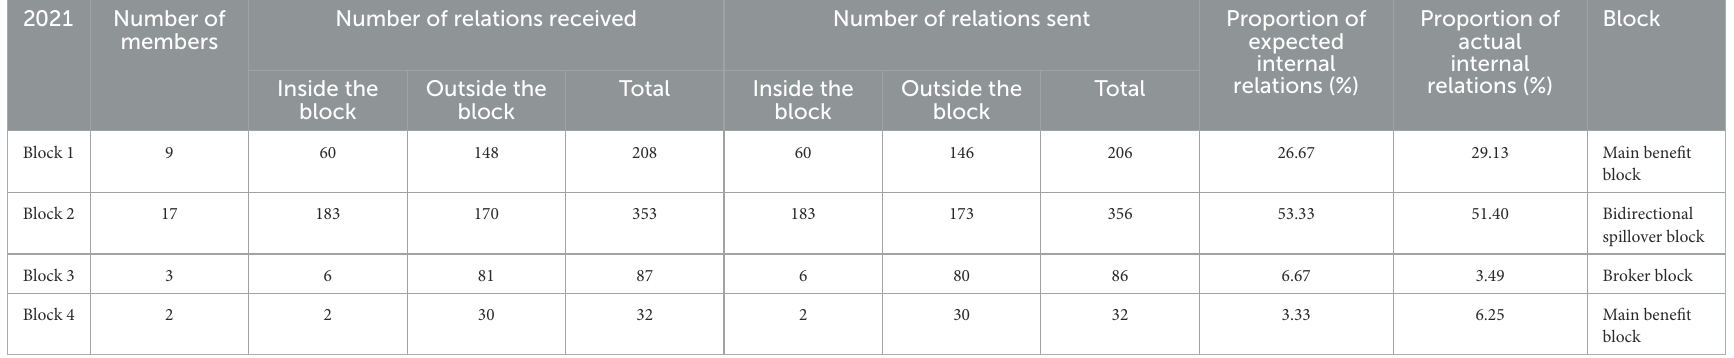
TABLE 6 Segmentation of China’s low-carbon patent cooperation network in 2021. 2021 Number of